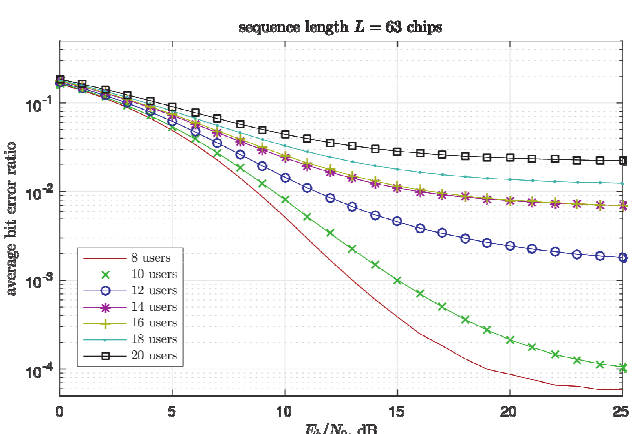
Fig. 8. Asynchronous DS-CDMA: BER performance in case of 63-chip-long chaotic spreading sequence.